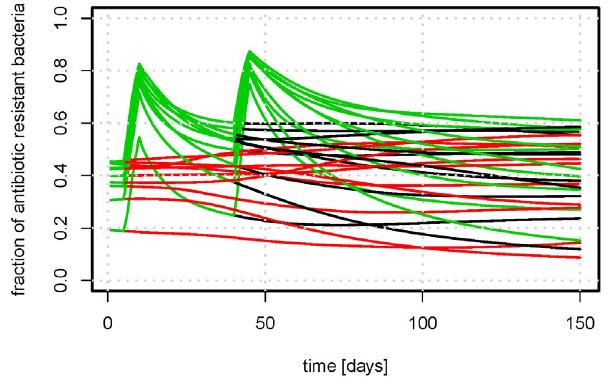
Figure 7. The variation of the repeats from figure 6. Fraction of antimicrobial resistant bacteria as a function of time with antimicrobial treatment. The AMT are indicated by color: red: no treatment, black: treatment from day 5 to 10, green: additional treatment day 35 to 40. The graph depicts 10 repeats with different compositions of initial strains. ( n pp ~ 15 , n p ~ 2 , j ~ 10 { 3 , Q ~ 0 : 01